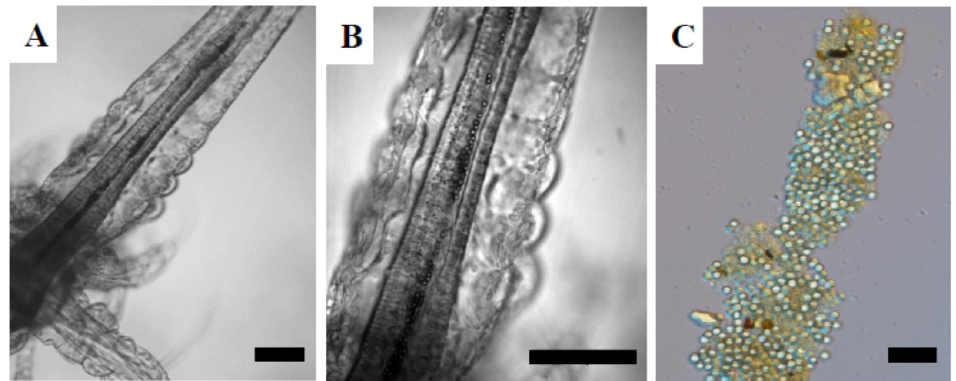
Figure 2. Brine shrimp larvae exposed to 4.5 µm MPs. ( A ) 24 hph larva exposed to 50.1 mg/L for 48 h; ( B ) 4.5 µm MPs in the digestive tract of the larva shown in ( A ) at higher magnification; ( C ) feces of brine shrimp larvae exposed to 50.1 mg/L. Scale bars: 100 µm ( A – B ) and 25 µm ( C ). The bioavailability of fluorescent 50 nm NPs, of 500 nm NPs and 4.5 µ m MPs